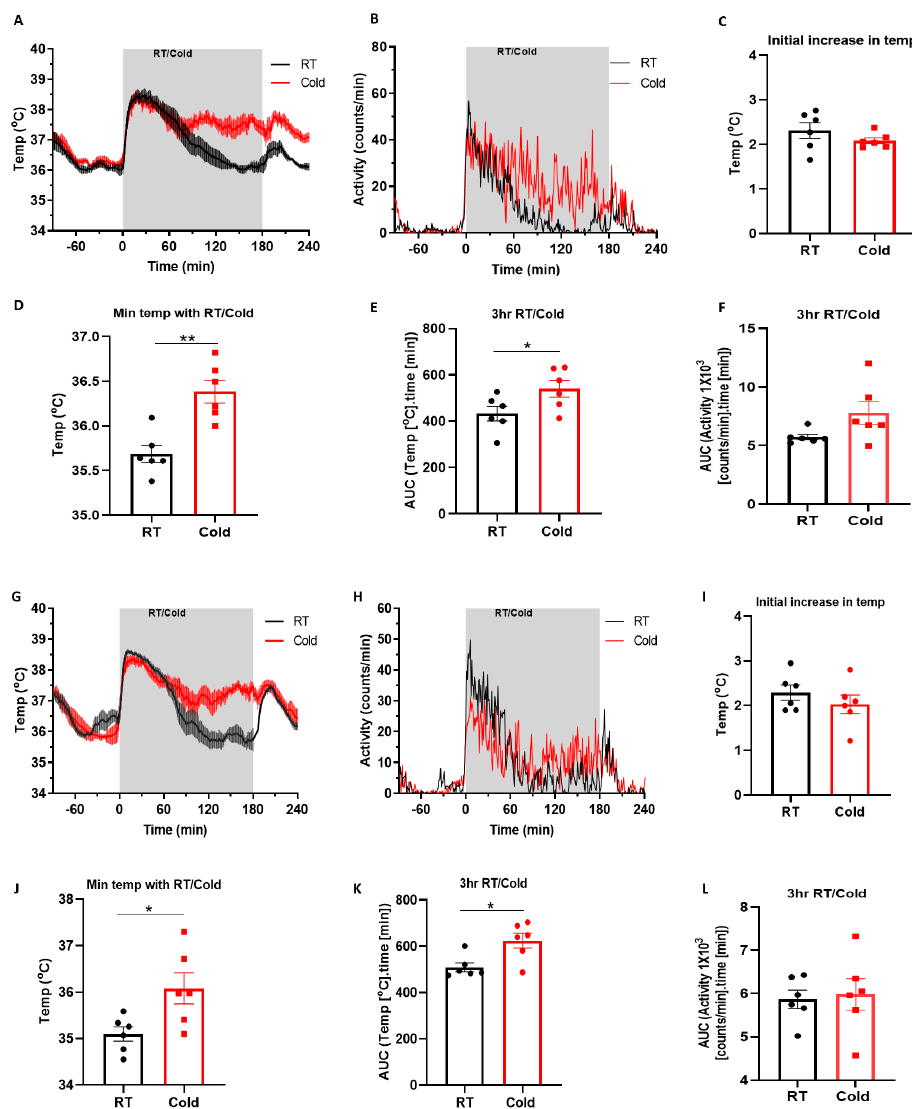
Figure 1. The effect of environmental cold in two different mice strains ( A–F ) Graphs for the CD-1 mice represent ( A ) the mean core body temperature and ( B ) the mean activity changes in the CD1 mice during 3 h of cold (4 °C) exposure in a climatic chamber or room temperature treatment (RT) ( n = 6). ( C ) the initial temperature increase at the start of cold exposure in climatic chamber or RT treatment; ( D ) the minimum temperature that was achieved during 3 h of RT/cold exposure; ( E ) the area under the curve (AUC) analysis of temperature during 3 h of RT/Cold treatment; ( F ) the area under the curve (AUC) analysis of the activity during 3 h of RT/Cold treatment. The results are for n = 6 mice. ( G–L ) Graphs for C57BL/6 mice represents ( G ) the mean core body temperature and ( H ) the mean activity changes in mice during 3 h cold (4 °C) exposure in a climatic chamber or RT